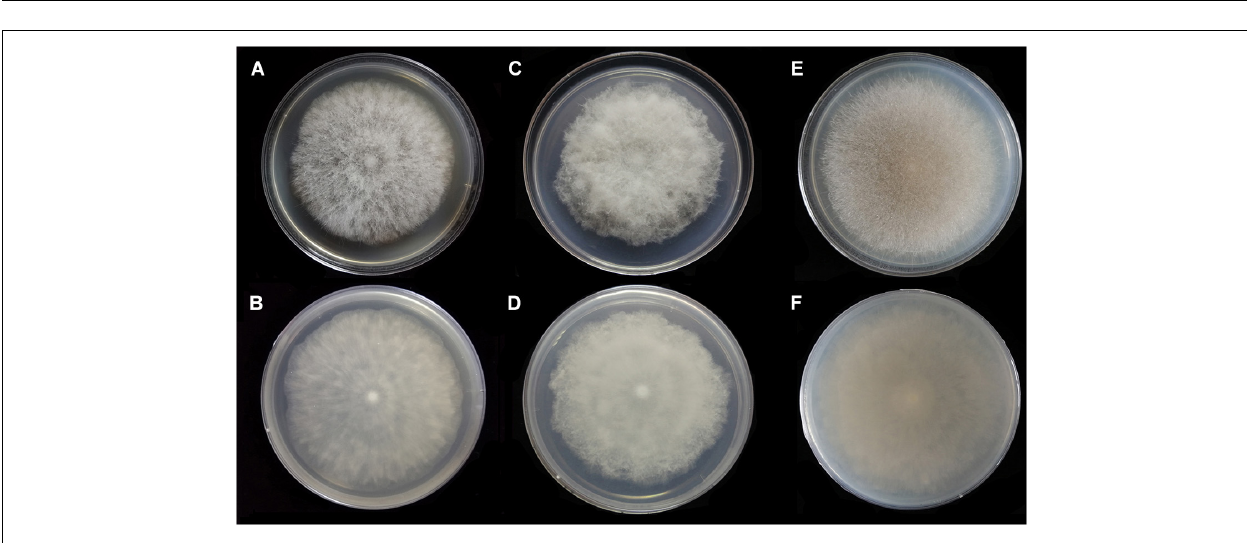
lid of the petri dish, white at first and then drab to hair brown (R45). No growth at 33 ◦